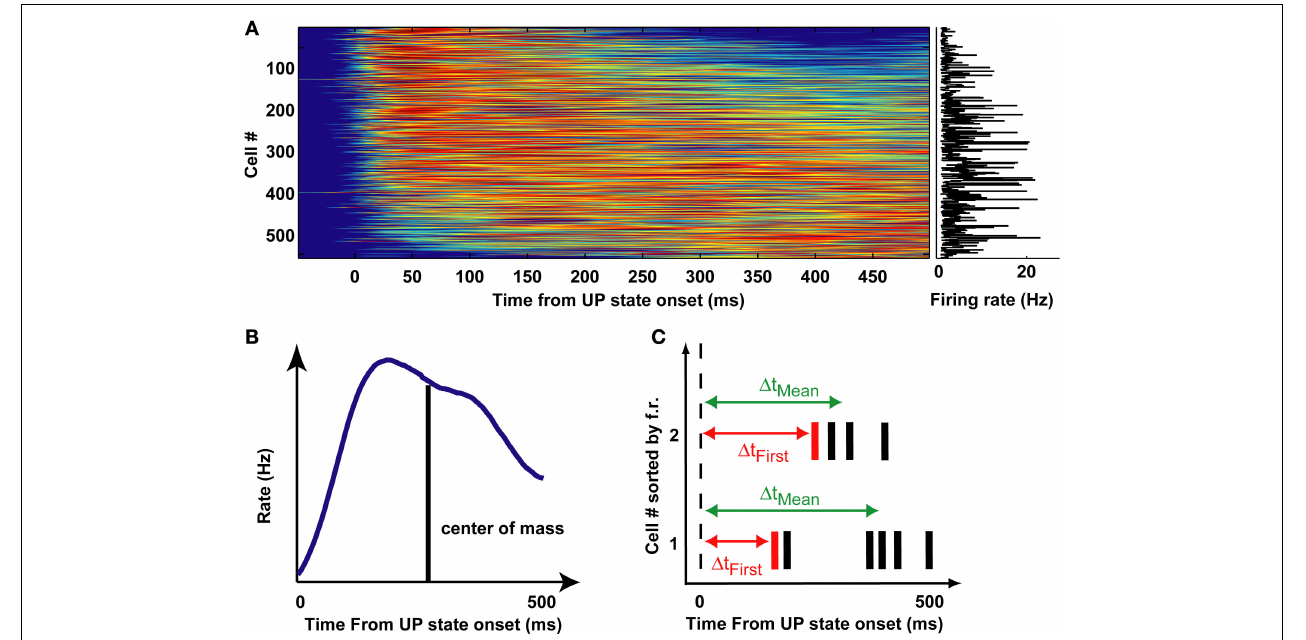
FIGURE 1 | Sequential activation of averaged activity at UP state onset. (A) PETHs of pyramidal cells, triggered on DOWN/UP state transitions from all recording sessions, sorted by their center of mass in the fi rst 500 ms after UP state onset. Color displays normalized PETH magnitude (red: high, blue: low).